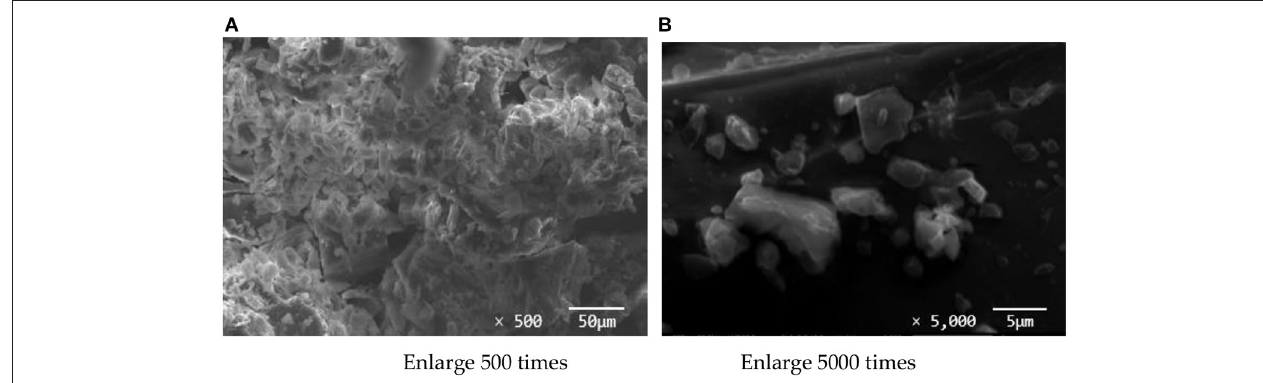
FIGURE 22 | SEM images of polyester-based TPU-modified asphalt. (A) Enlarge 500 times. (B) Enlarge 5000 times.